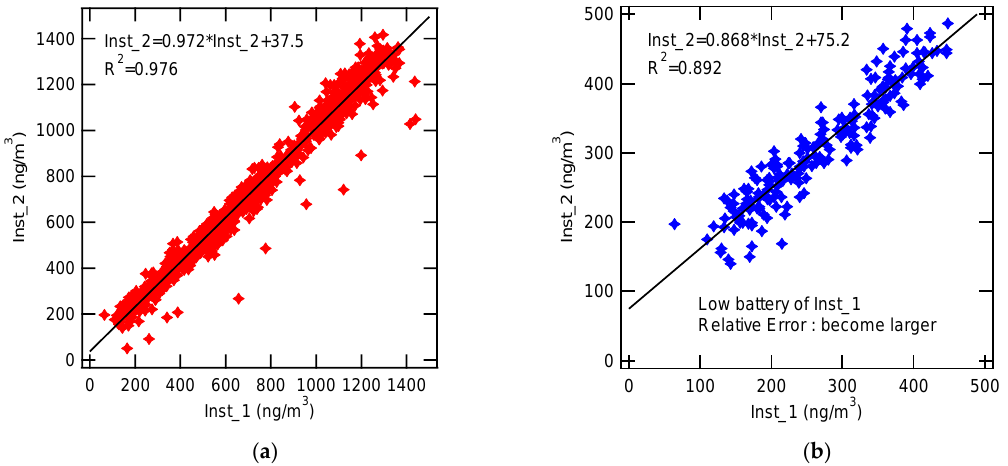
Figure 3. Comparison of both devices for ( a ) the whole period shown in Figure 1 and ( b ) the period while the battery status of Inst_1 was low.